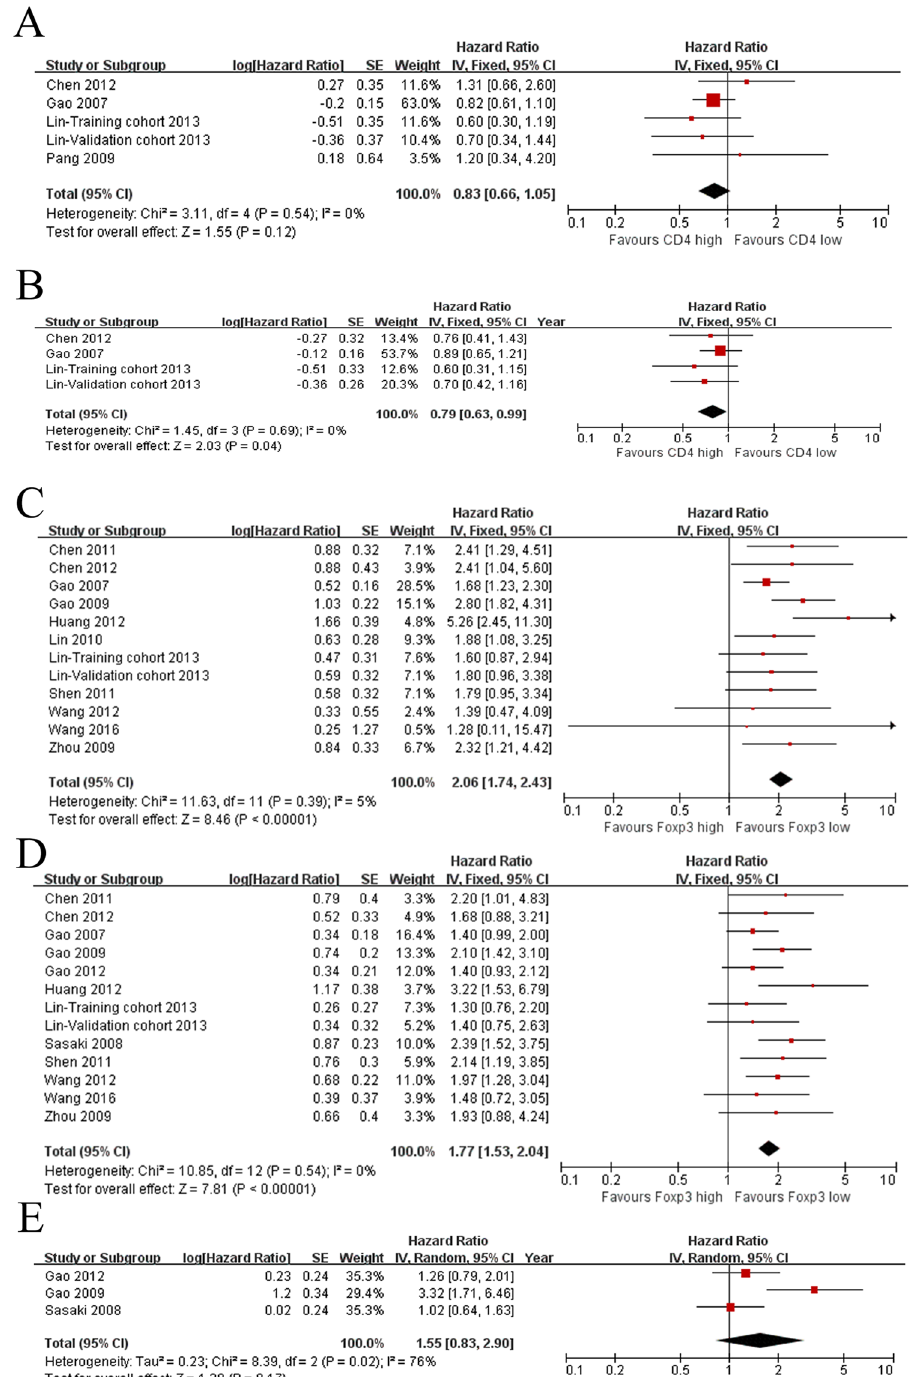
Figure 2. Forest plots of relationships between levels of CD4 + and Foxp3 + T lymphocytes and survival. ( A ) The effect of CD3 + T lymphocytes on OS. ( B ) The effect of CD3 + T lymphocytes on DFS/RFS. ( C ) The effect of Foxp3 + T lymphocytes on OS. ( D ) The effect of Foxp3 + T lymphocytes on DFS/RFS. ( E ) The effect of Foxp3 + T lymphocytes on